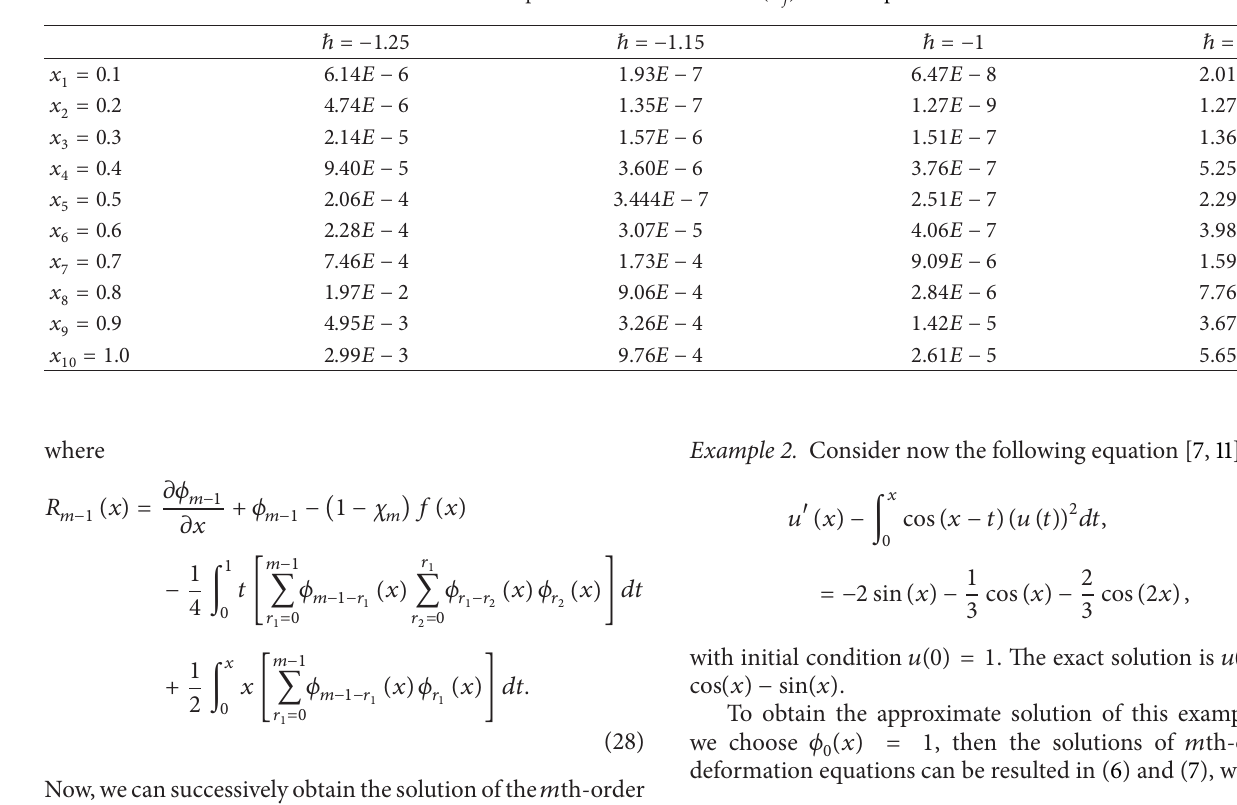
Table 4: Comparison of relative errors 𝛿(𝑥 𝑗 ) for Example